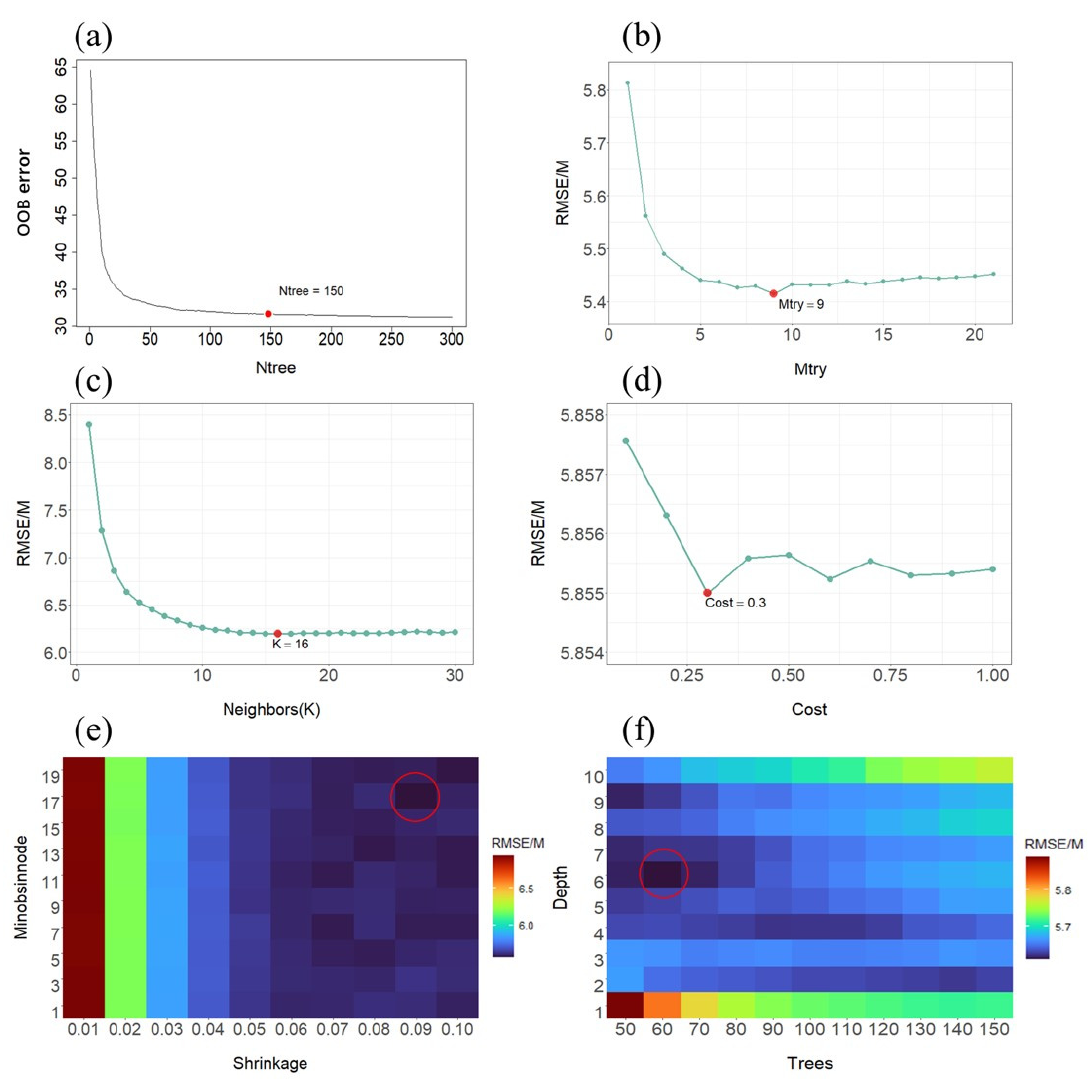
Figure 5. Parameters in the machine learning model selected based on cross-validation. ( a ) Ntree in the RF, ( b ) Mtry in the RF, ( c ) K in the KNN, ( d ) cost in the SVM, ( e ) Minobsinnode and Shrinkage in the GBDT, ( f ) Depth and Trees in the